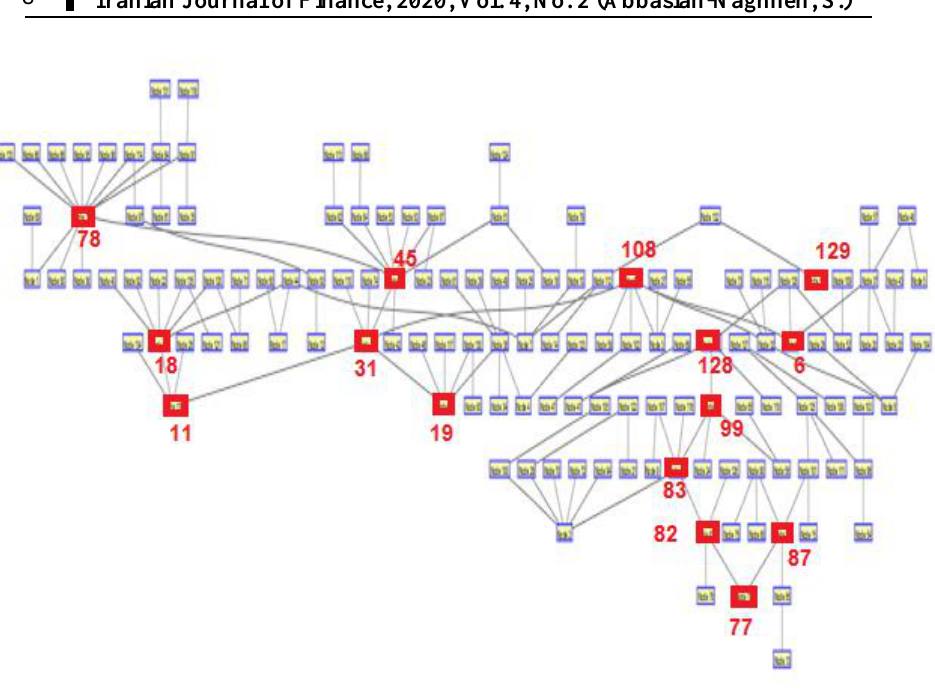
Figure 1. The minimum spanning tree of the examined network